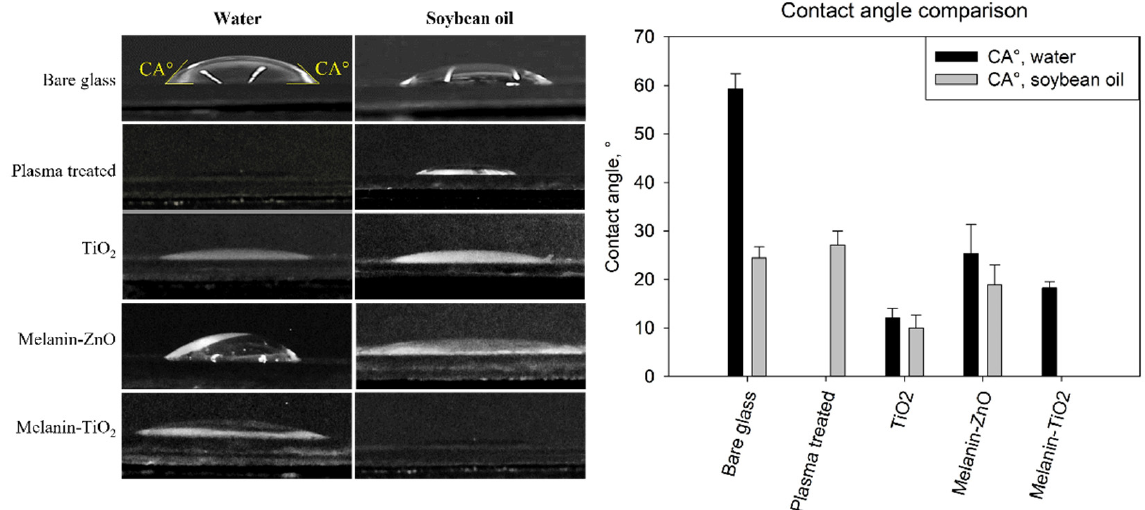
Figure 3. Side views of 30 µ L droplets of water and soybean oil. Experiments are conducted in triplicates for each type of sample (nanoparticles of melanin/ZnO, TiO 2 , and melanin/TiO 2 ). After 48 h of growth on bare glass and different functionalized samples (melanin/ZnO, melanin/TiO 2 , and TiO 2 ), Pseudomonas fluorescens biofilms were stained with the LIVE/DEAD kit before CLSM acquisitions. For each type of coating, three different samples were analyzed and for each sample, a 3D mosaic scan [47] (3 × 3 × 15–20 layers, depending on biofilm thickness) was acquired. Using biofilm growth on bare glass as the control experiment, the effect of the nanoparticle coatings is shown by comparing the functionalized samples with the unfunctionalized one (a single field of view of mosaic scan is reported in Figure 4).